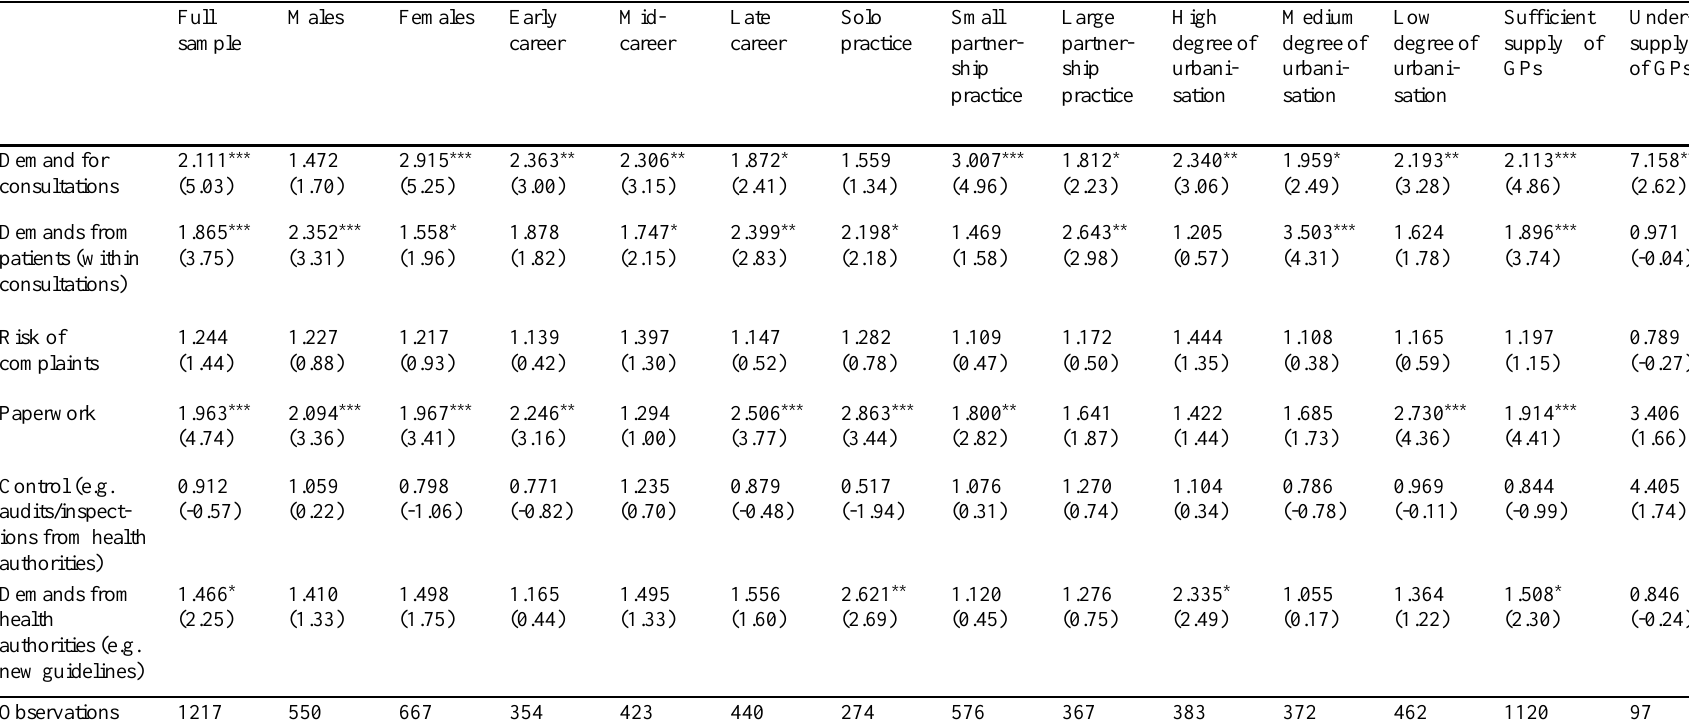
Table 2: Ordered logit models estimating the association between measures of pressure and job